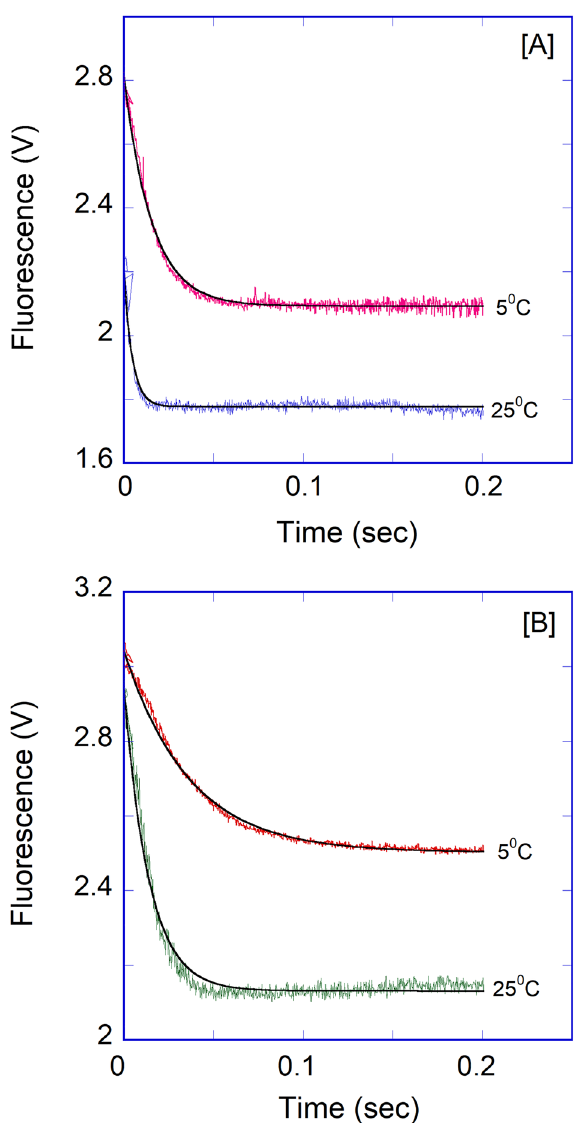
Figure 10. Representative temperature-dependent time course for the interaction of APP IREmRNA with IRP1. Kinetic data show the time-dependent decrease in fluorescence values after rapid mixing of ( A ) APP mRNA and ( B ) APP mRNA∙Fe 2+ with IRP1 protein at 5 °C and 25 °C. APP mRNA and IRP1 concentrations were 1 μM (final) and 0.1 μM (final). Concentration of Fe 2+ was 50 μM. The solid line represents the fitted curve for a single-exponential function. The experimental conditions are described in the Methods